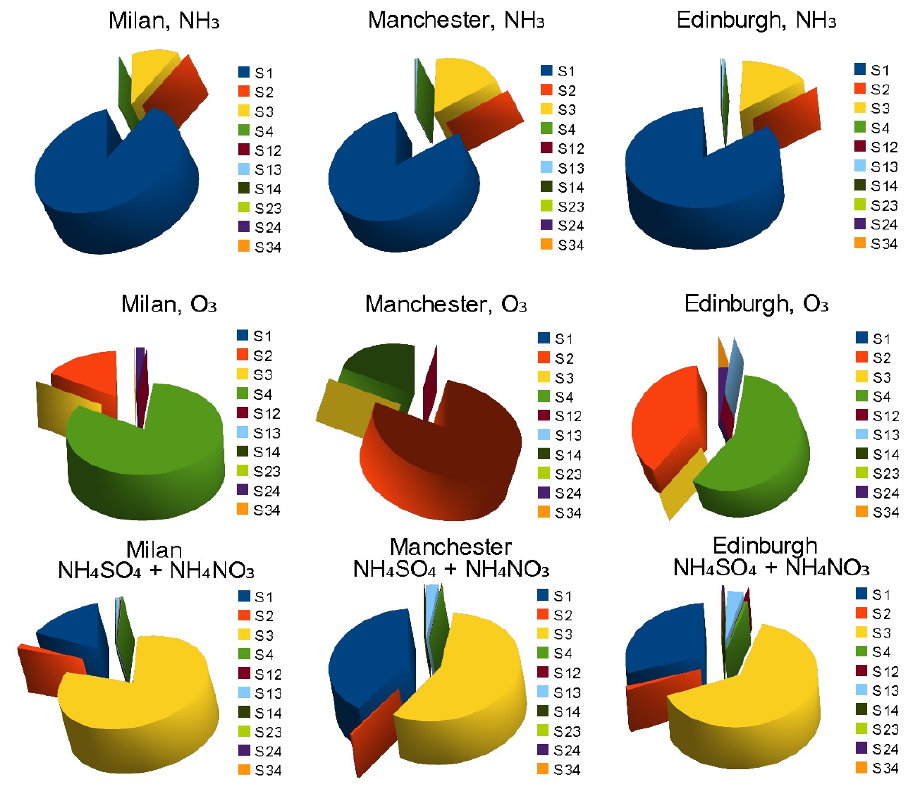
Figure 1. Pie charts representation of first- and second-order sensitivity indices of the ammonia, ozone, and ammonium sulphate and ammonium nitrate in Milan, Manchester, and Edinburgh (January 1997).